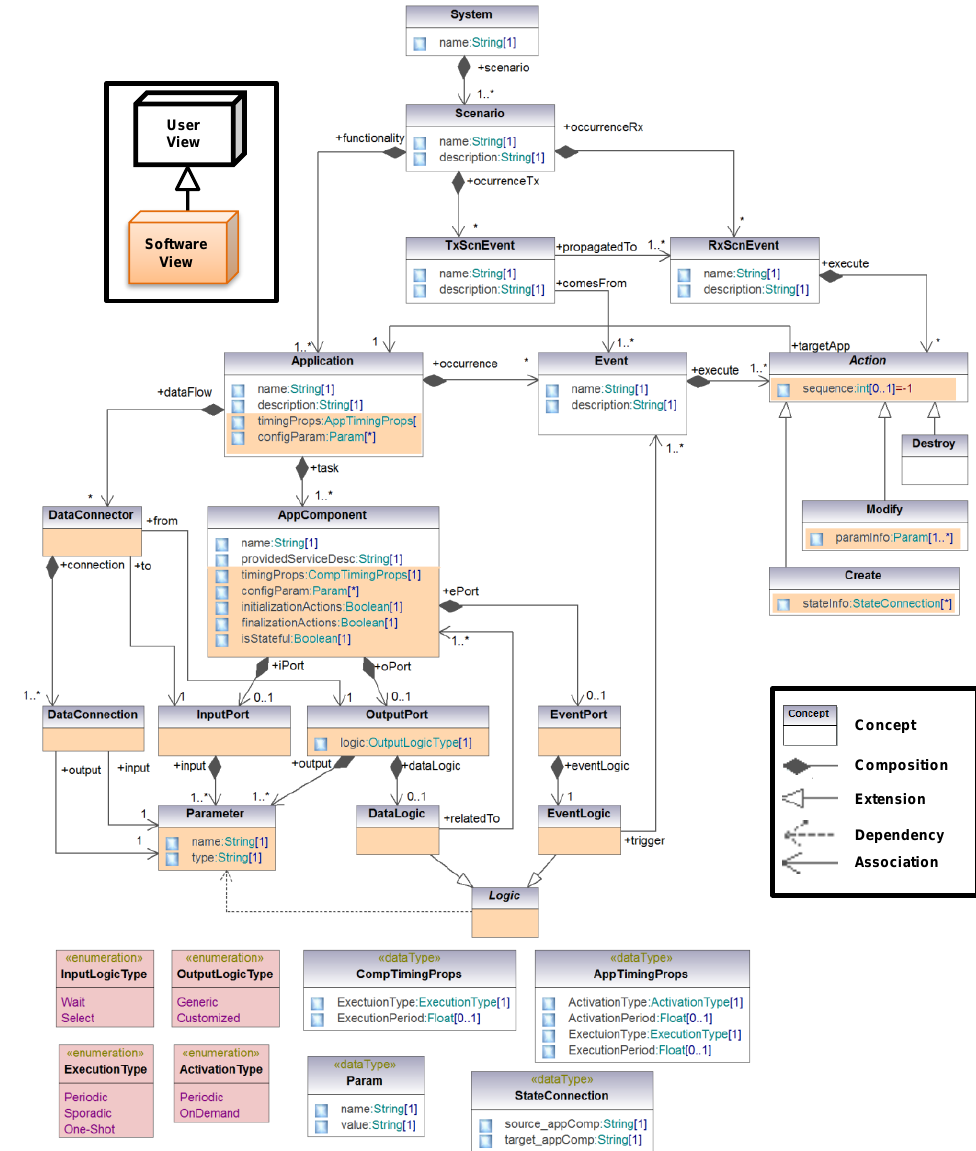
Figure 4. Meta-model of the domain modeling approach for application specification.